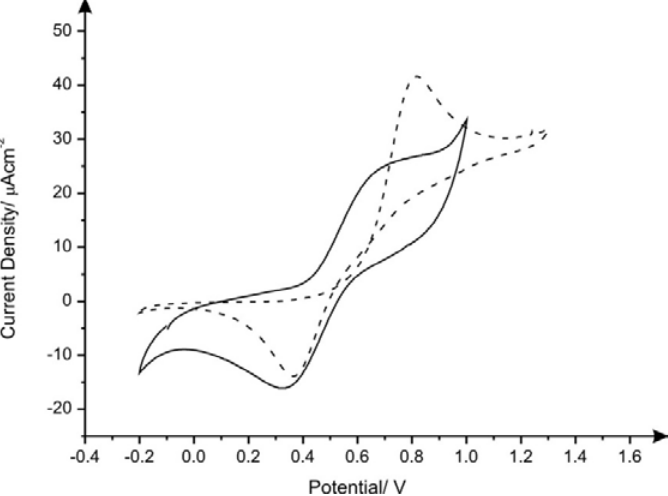
Figure S5. Comparison of cyclic voltammograms using PDE1 (solid line) and SPE (dotted line) recorded in 1 mM ammonium iron(II) sulphate/0.2 M HClO 4 . Scan rate: 5 mV·s − 1 .